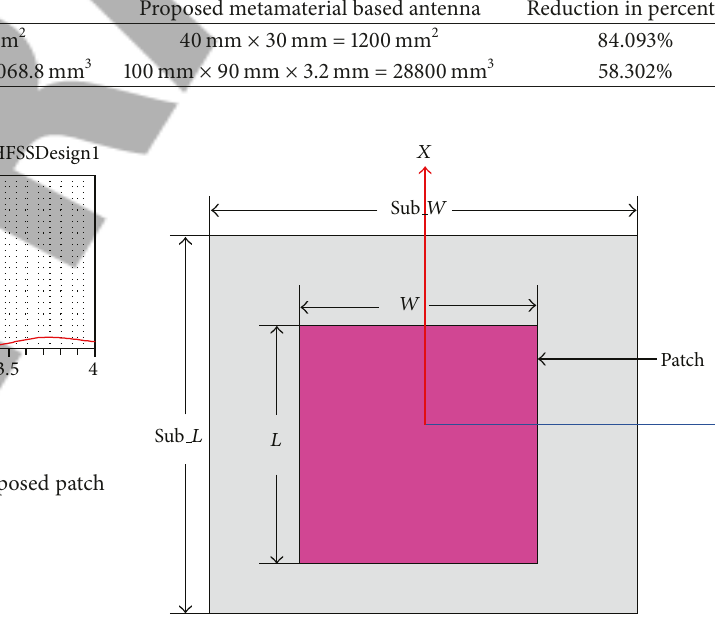
Figure 7: Conventional microstrip